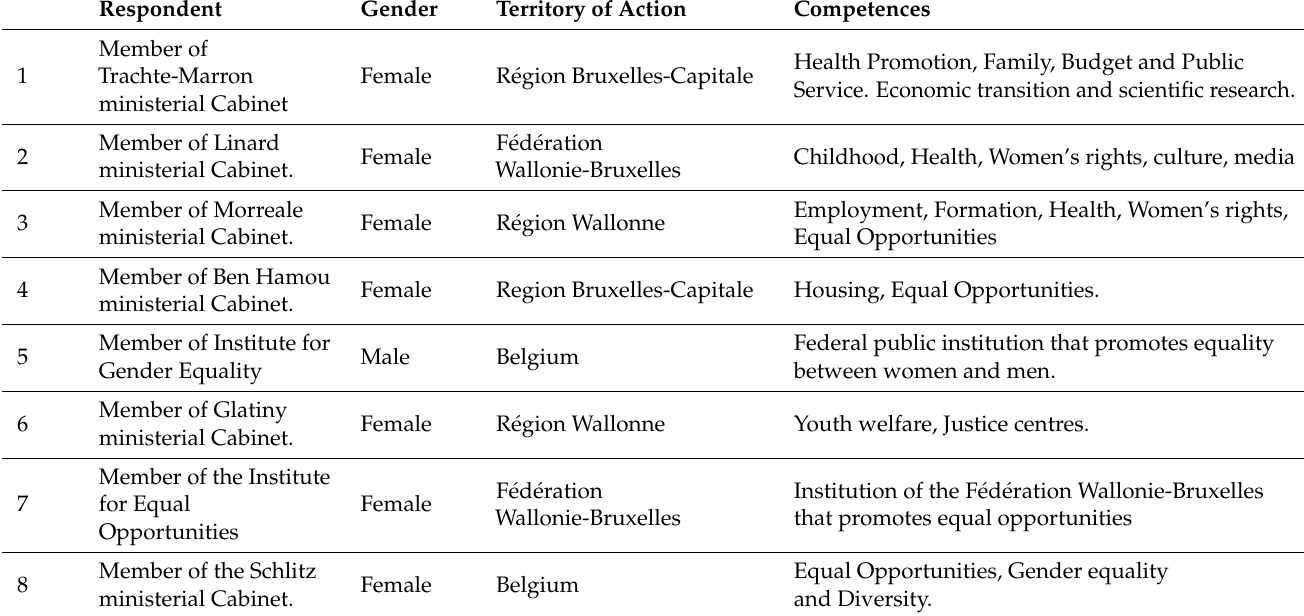
Table 2. Summary table of interviews with the members of administrations and political